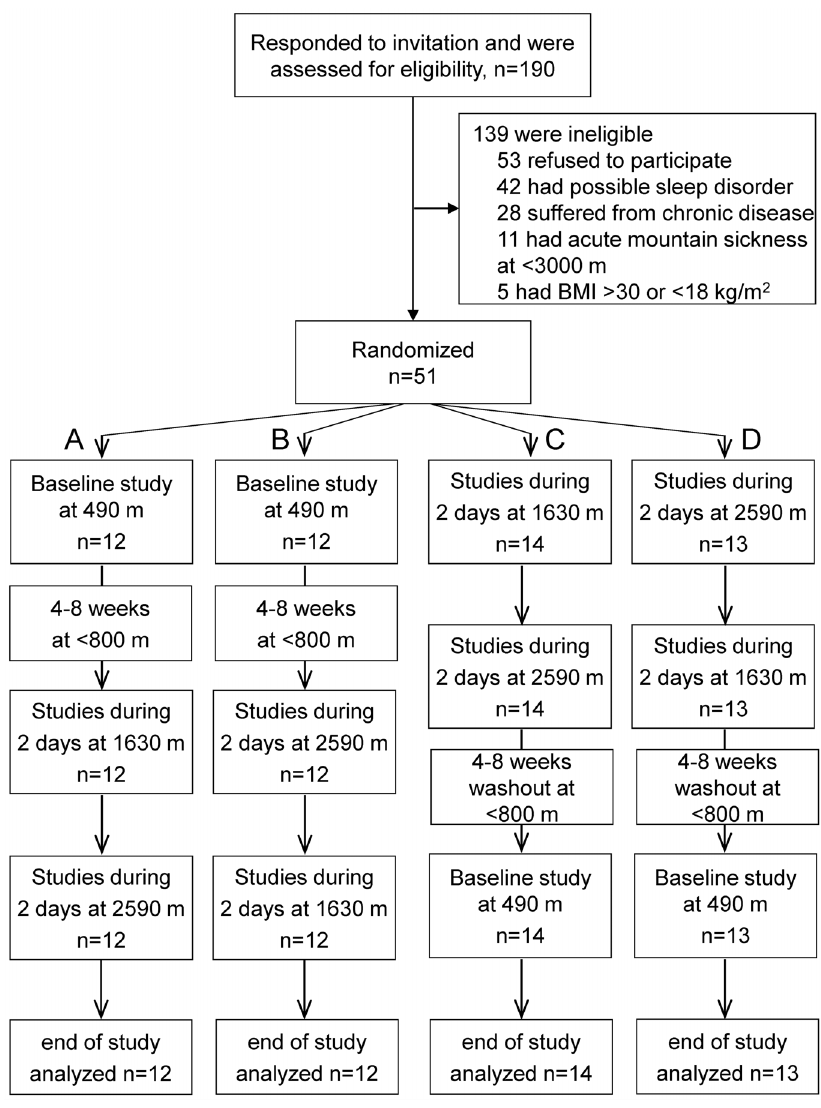
Figure 1. Study flow.